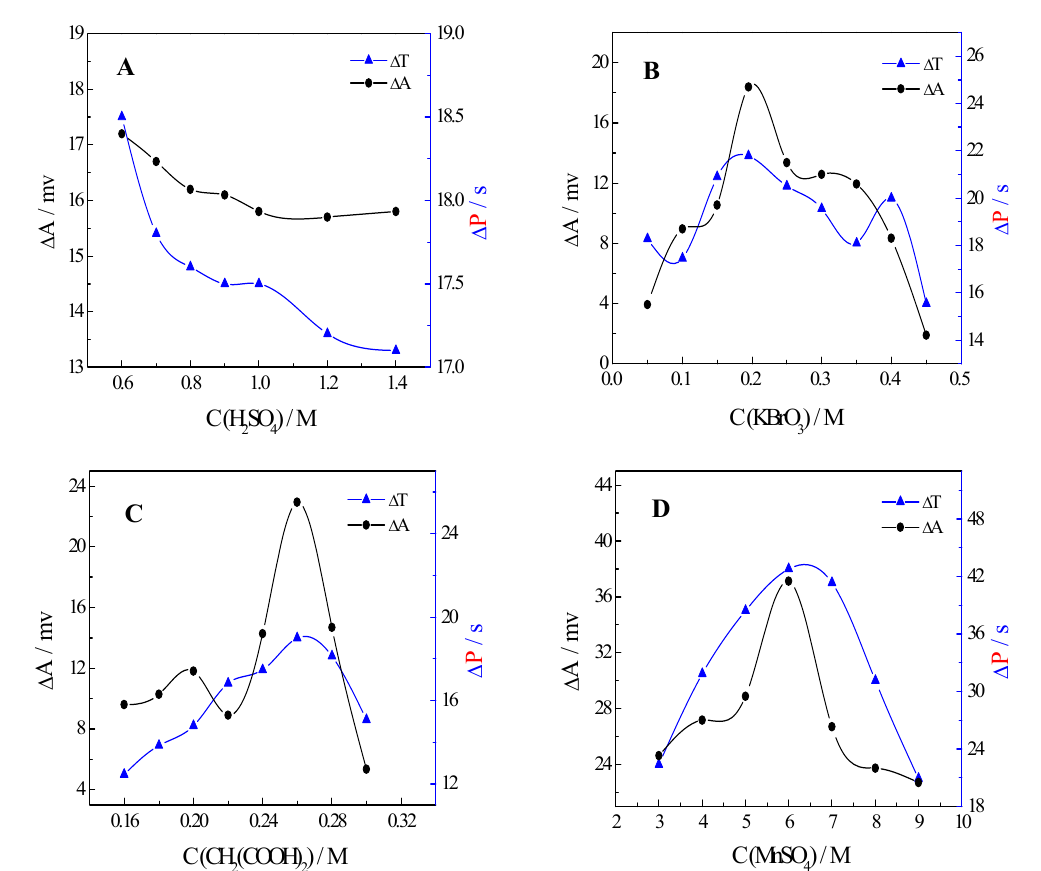
Fig. 3 Influence of the concentrations of H 2 SO 4 (A), KBrO 3 (B), CH 2 (COOH) 2 (C), and MnSO 4 (D) on the sulfanilamide-perturbed oscillating system (the symbol • refers to amplitude change and (cid:2) refers to period change). Experimental conditions: T = 35 ◦ C, overall flow rate 1.4 ml · min − 1 , [SNA] = 0.750 µ mol; (A) 6.00 × 10 − 3 mol · L − 1 MnSO